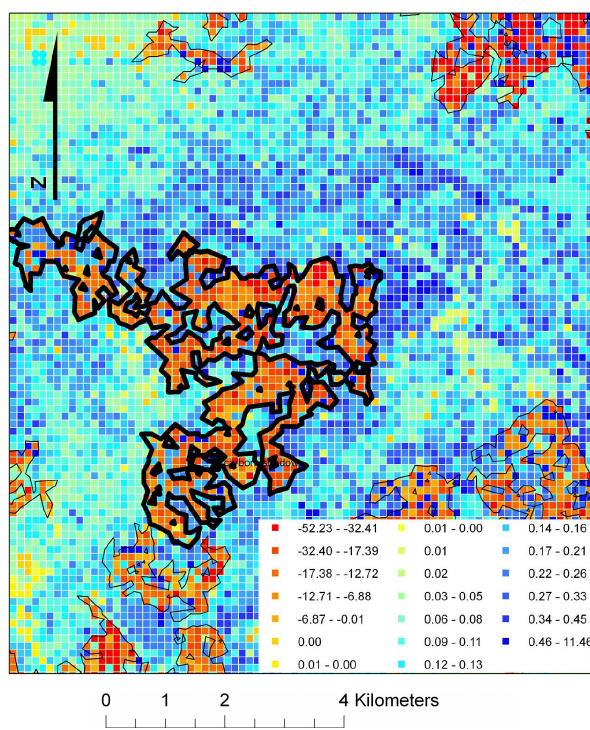
Fig. 6. Zoomed image from Fig. 5 showing expected carbon differences (tonnesha − 1 ) between the non-treatment and treatment scenario. Treatment units are hatched polygons. Dominant fire spread direction is from the southwest to northeast. Image shows positive expected carbon on the outside of treated areas (blue pixels) where treatments impeded growth of simulated